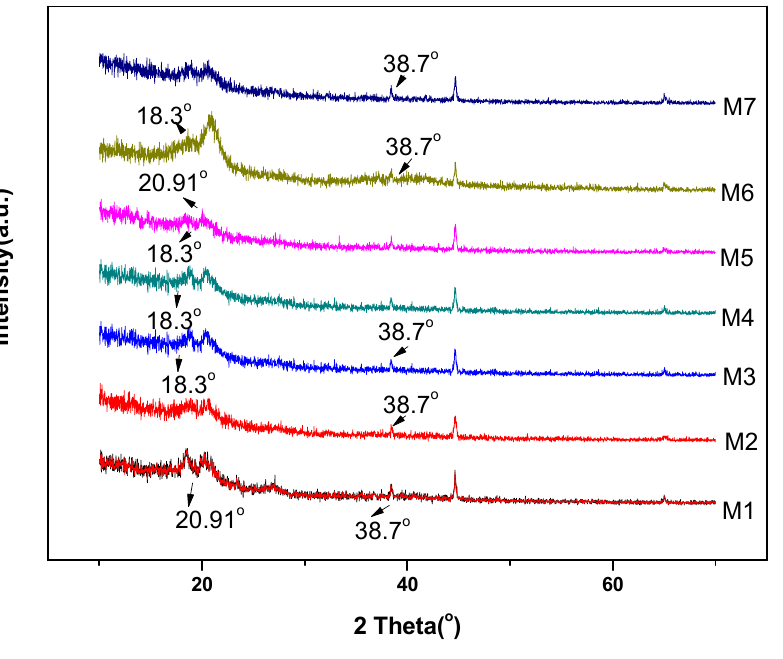
Figure 5. XRD spectra of nanocomposite membranes.